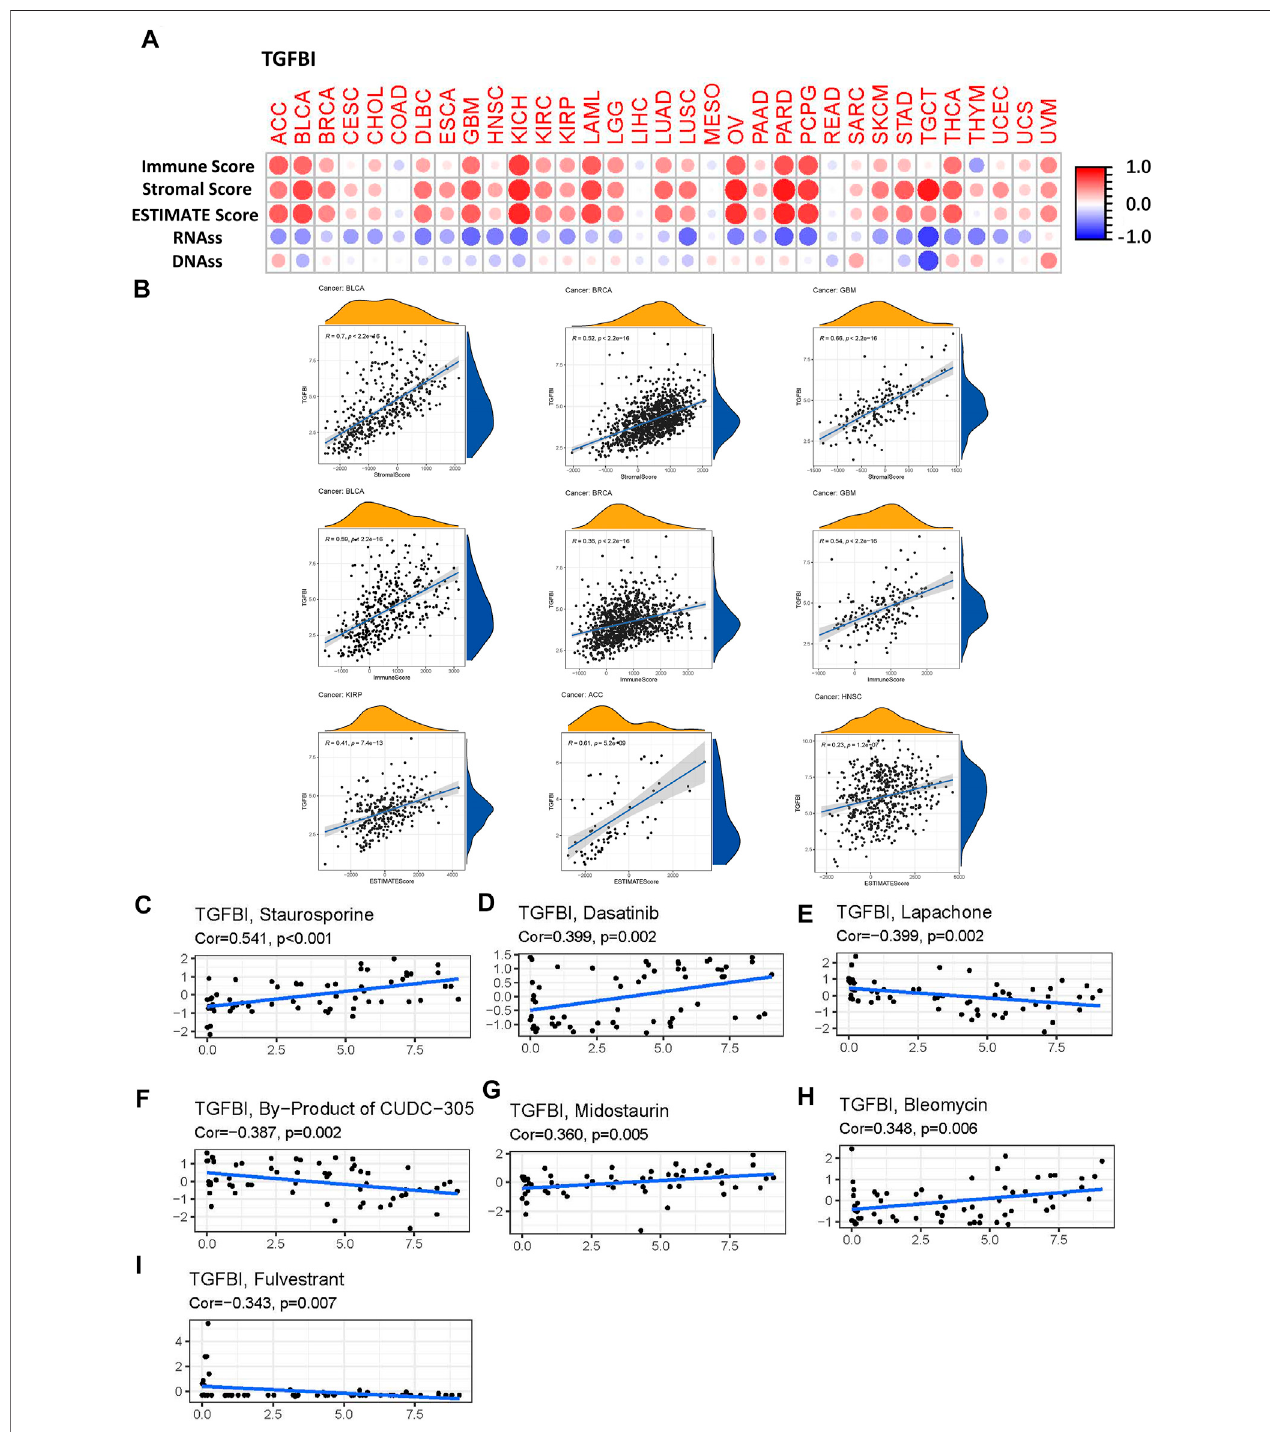
FIGURE 8 | Correlation matrix of TGFBI expression with tumor microenvironment (TME) components, stemness scores, and drug sensitivity in a pan-cancer analysis. (A) TGFBI expressionwascorrelatedwithESTIMATEscore,immunescore,stromalscore,RNAss,andDNAssinvariouscancers.Redandbluedotsindicatea positiveandnegativecorrelation,respectively,between TGFBI expressionincancerandimmune/stromalscore. (B) Topthreescatterplotsofcorrelationbetween TGFBI and stromal score, immune score, ESTIMATE score in various cancers. TGFBI expression was positively associated with (C) staurosporine, (D) dasatinib, (G) midostaurin, and (H) bleomycin sensitivity, and negatively associated with (E) lapachone, (F) CUDC-305 byproduct, and (I) fulvestrant sensitivity. R represents the correlation coef fi cient, Cor represents correlation.